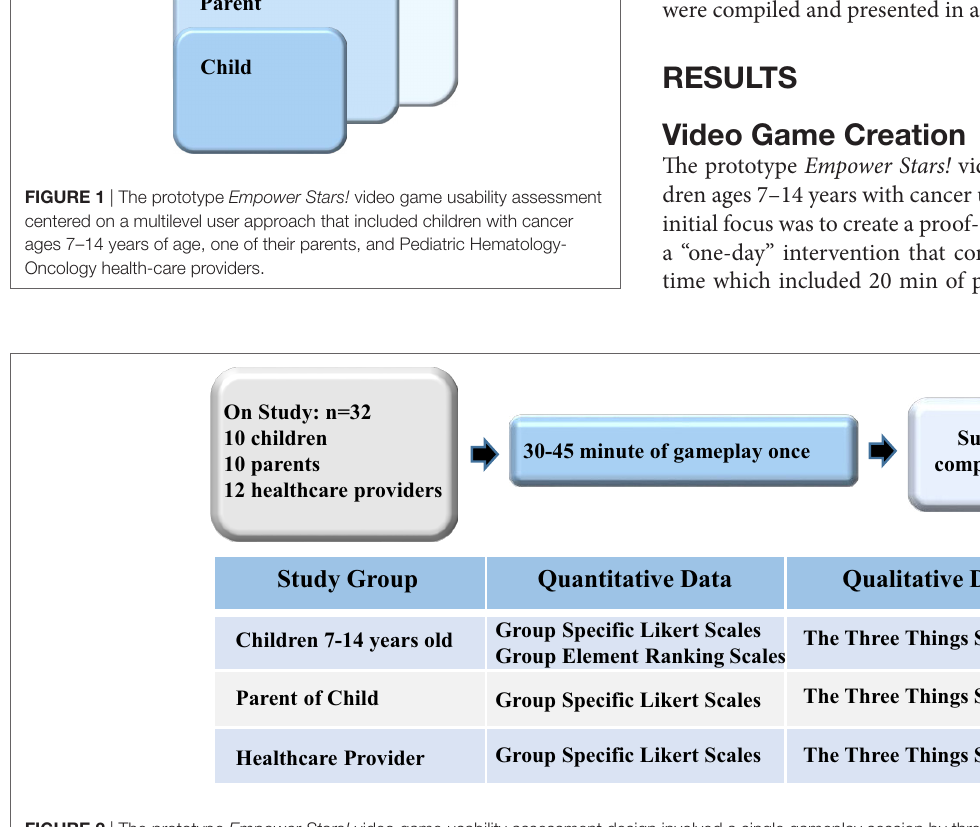
Healthcare Provider